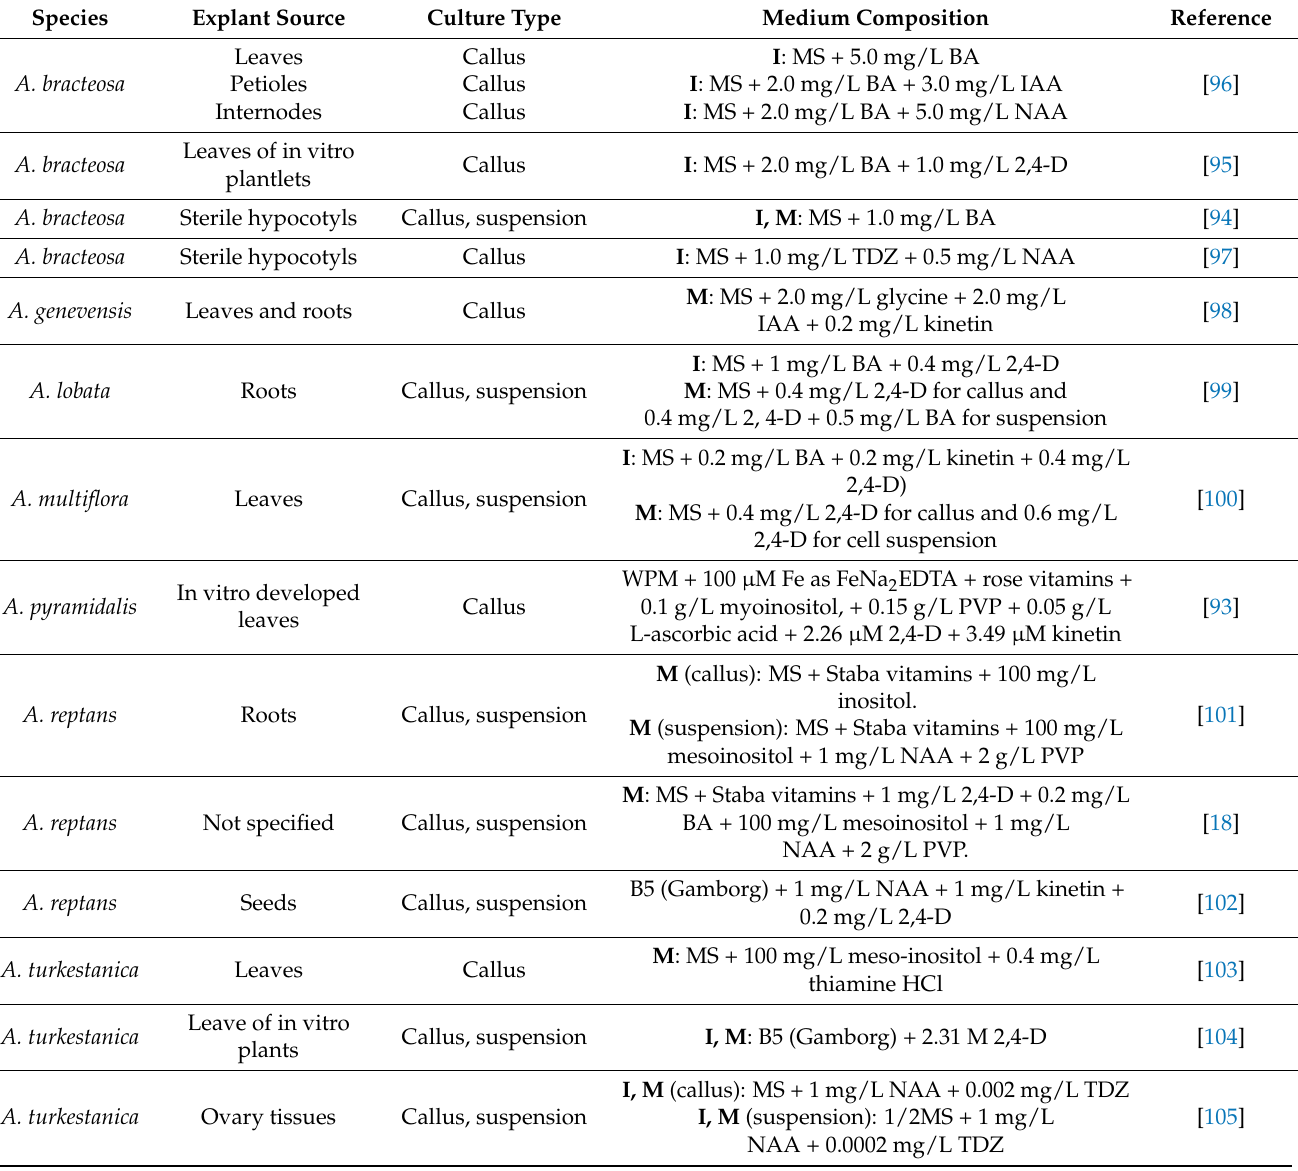
Table 2. Examples of nutrient media and explant sources used for cell culture induction (I) and maintenance (M) in various Ajuga